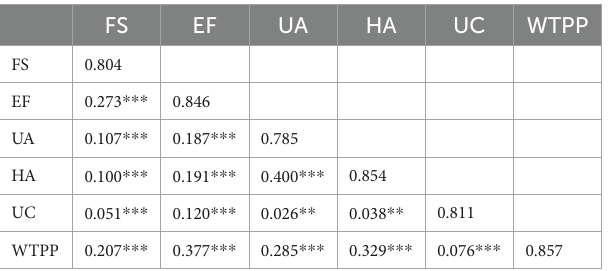
TABLE 7 Results of the moderating effect